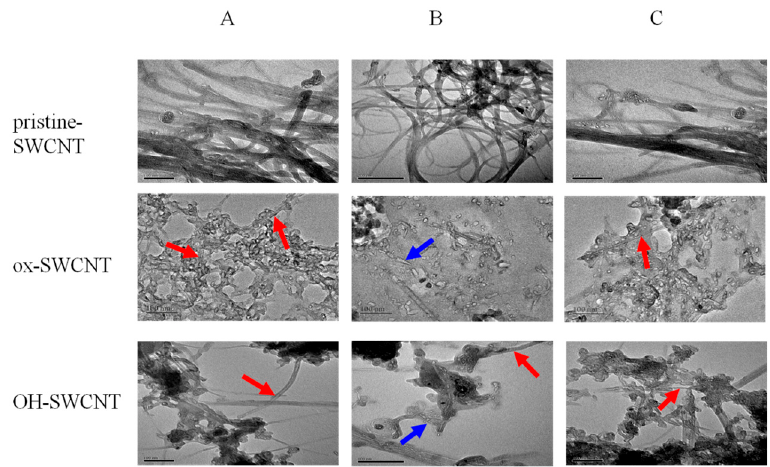
Figure 8. TEM imaging of SWCNTs (pristine-SWCNT, ox-SWCNT, OH-SWCNT) after 24 h incubation with in vitro respiratory burst enzymatic system. ( A ) MPO only; ( B ) Full enzyme solution (MPO + SOD + NOX); ( C ) Full enzyme solution supplemented with 1 mM NAC. Red arrows point to SWCNTs with long fiber-like shape; Blue arrows point to degraded fragments of SWCNTs. Scale bar = 100 nm.